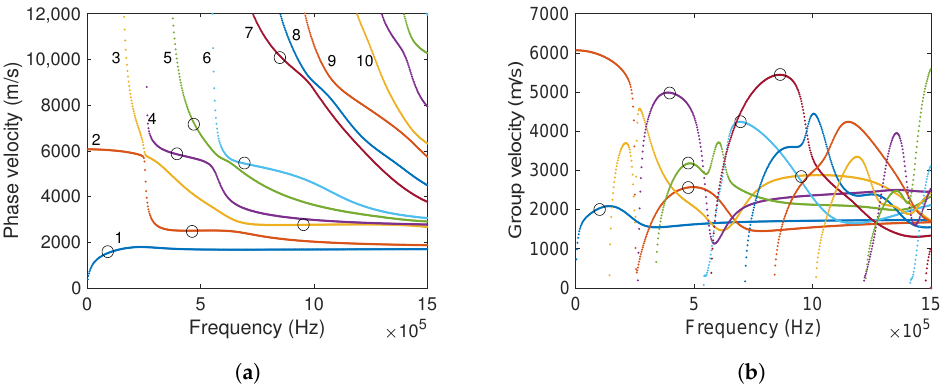
Figure 4. Dispersion curves of: ( a ) phase and ( b ) group velocities, calculated for the infinite aluminium-CFRP hybrid plate using SBFEM. The first ten guided wave modes are numbered in numerical order. The circles mark modes, as chosen for numerical modelling. Recreated from original data from [13].